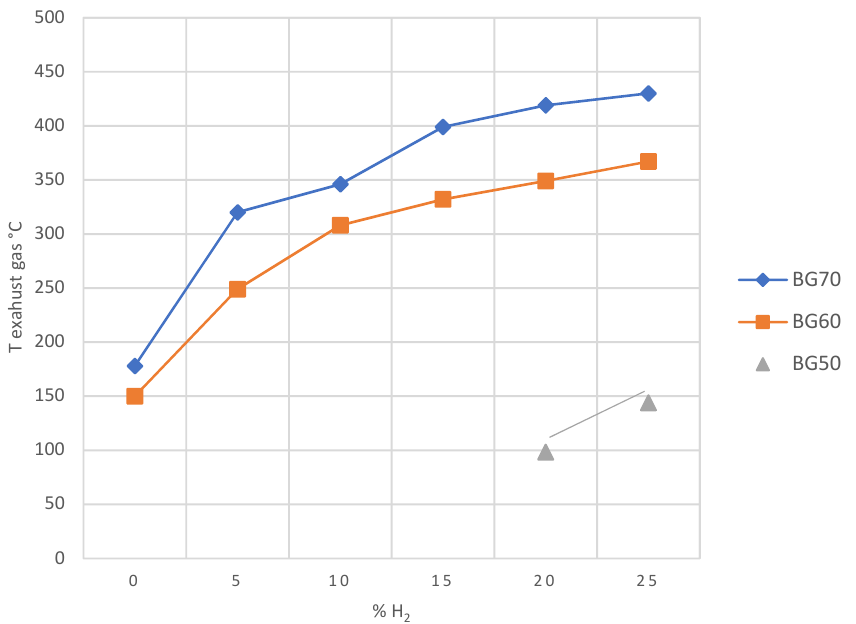
Figure 9. Exhaust gas stream temperature.